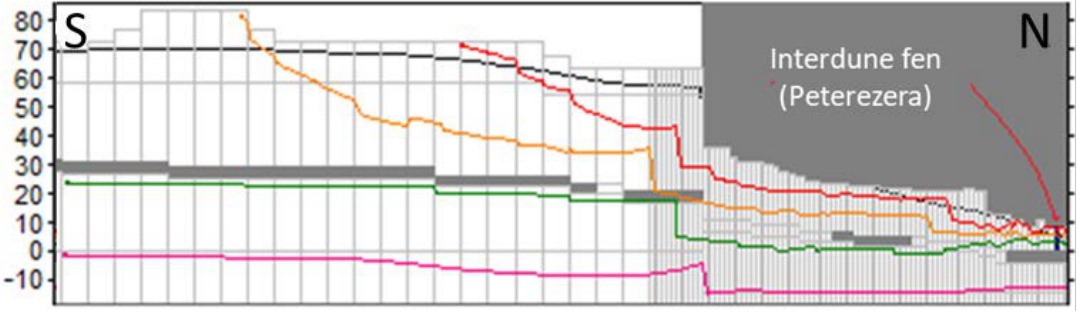
Figure 7. Cross section of the model tracking groundwater particles from the plateau to the inter-dune mire complex (Peterezera Mire): (i) infiltrating at the plateau (red and orange) and (ii) groundwater flow from the sandstone aquifer (green and pink).